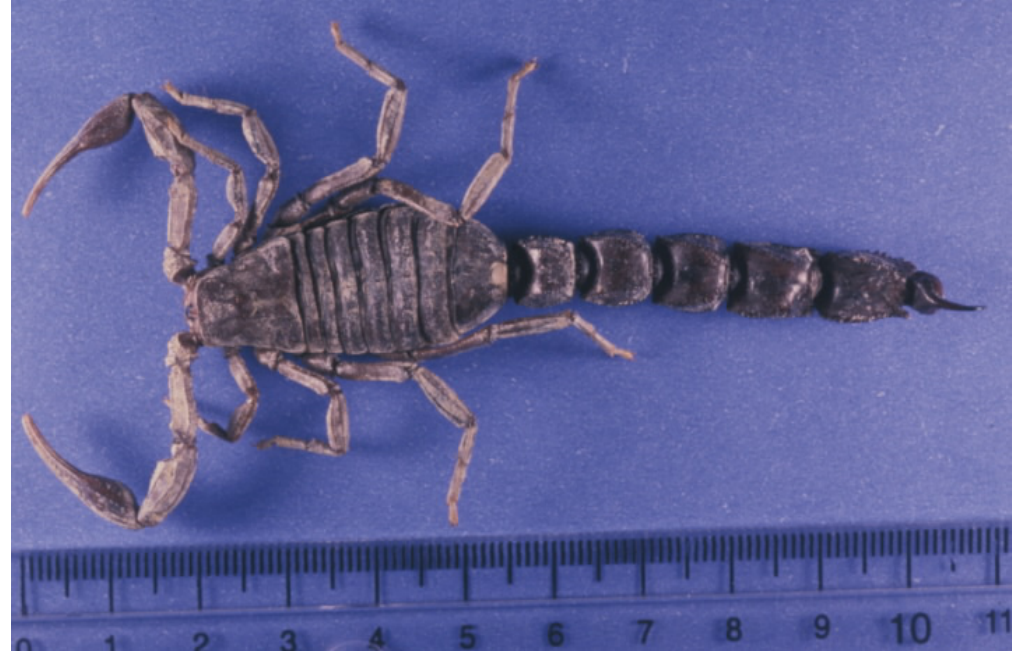
Figure 4: Androctonus crassicauda from Southeastern Anatolia [Photographed by Ozkan